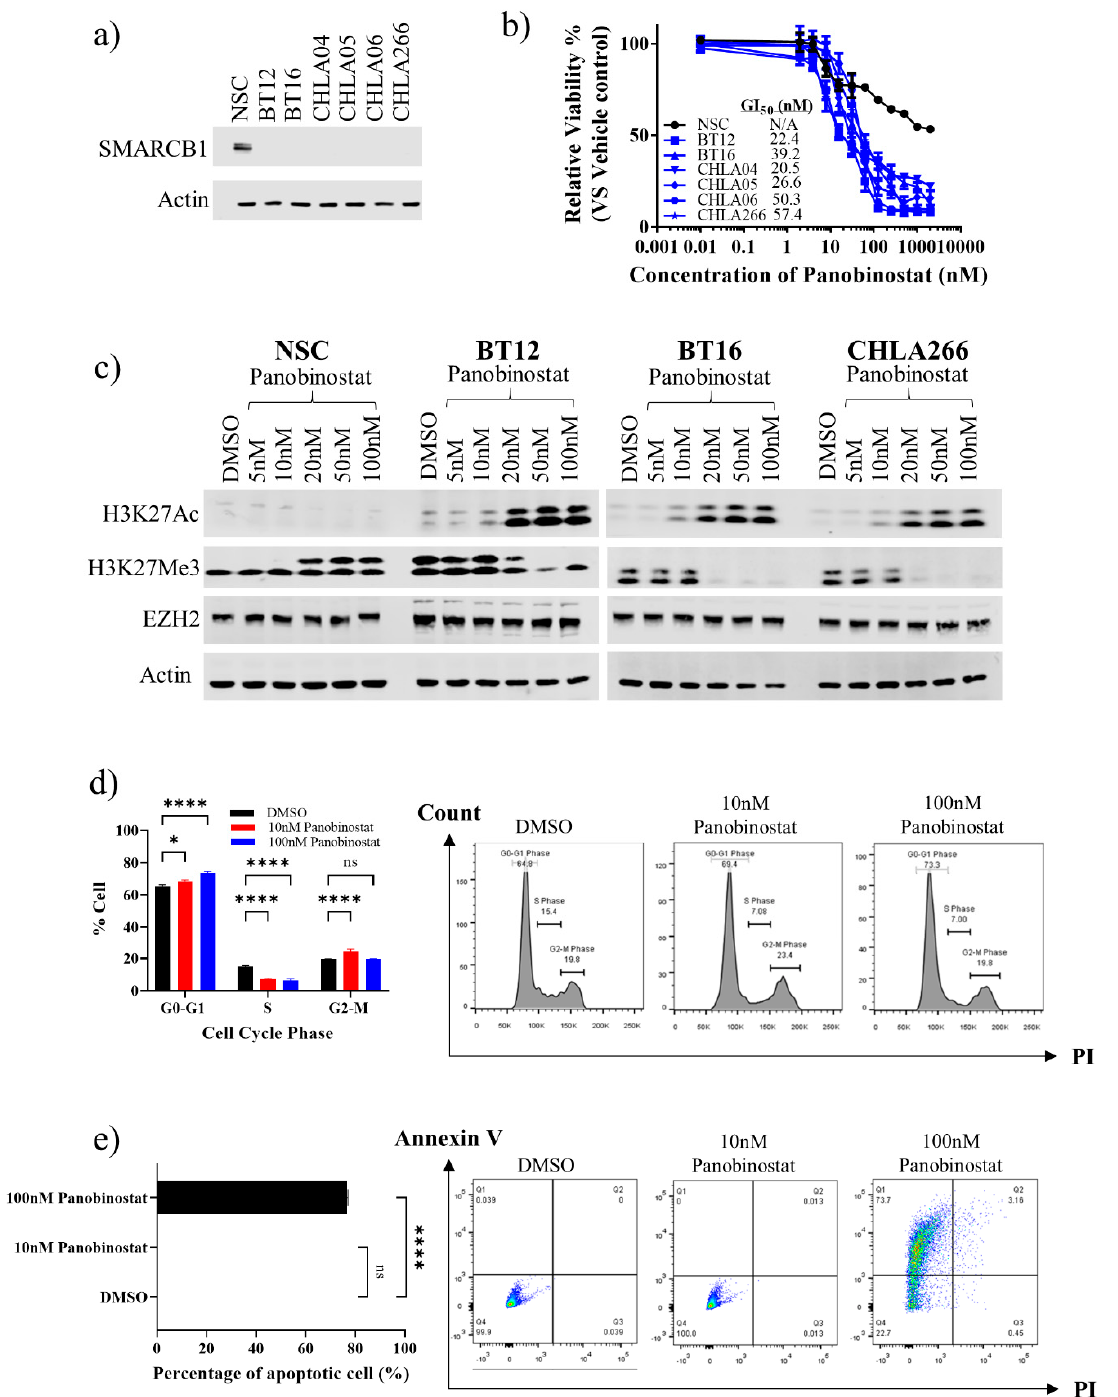
Figure 1. Response of human ATRT cell lines to the HDACi, panobinostat, following 72 h of treatment. ( a ) Analysis of SMARCB1 protein expression in human ATRT cell lines (BT12, BT16, CHLA04, CHLA05, CHLA06 and CHLA266) and human NSC. ( b ) Cell viability of ATRT cell lines and NSC treated with increasing concentrations of panobinostat (0.01–2000 nM). ( n = 4; mean ± SEM). ( c ) Western blot of histone H3 acetylation (H3K27Ac), methylation (H3K27Me3), EZH2 and Actin in SMARCB1-null ATRT cells (BT12, BT16, and CHLA266) and NSC cells after treatment with increasing doses of panobinostat (5–100 nM) for 72 h. ( d ) Cell cycle analysis of BT12 treated with increasing doses of panobinostat (10–100 nM) for 72 h ( n = 3; mean ± SEM; ns, not significant; *, p < 0.05; ****, p < 0.0001) ( e ) Annexin V assay of BT12 treated with increasing doses of panobinostat (10–100 nM) for 72 h ( n = 3; mean ± SEM; ns, not significant; ****, p < 0.0001). Apoptotic cells are defined as Annexin V +ve, PI − ve and Annexin V +ve, PI −